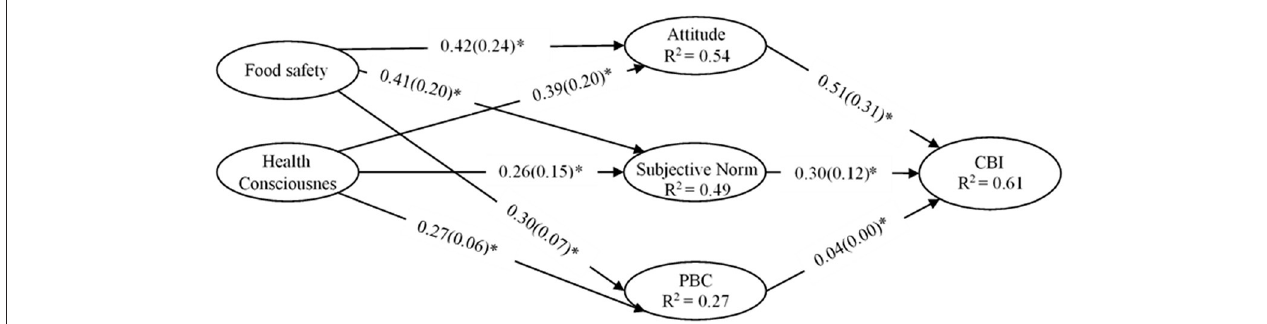
FIGURE 2 | Structural equation modeling ( SEM) results of complete data ( n = 462), PBC, Perceived Behavioral Control. The * indicates p -values < 0.01. The figure presents the effect sizes ( f 2 ) in the parentheses next to each path coefficient ( β